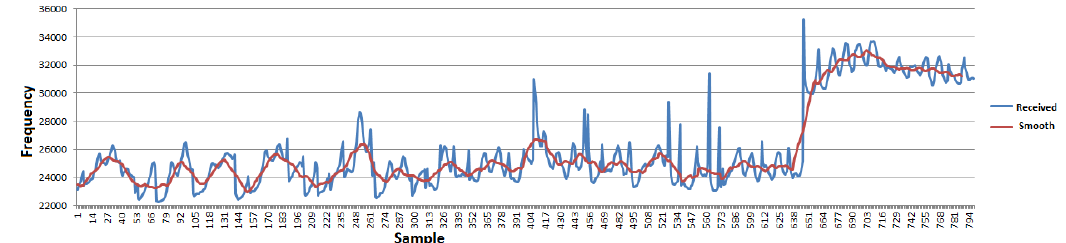
Figure 19. Smoothing the capacitive probe signal.